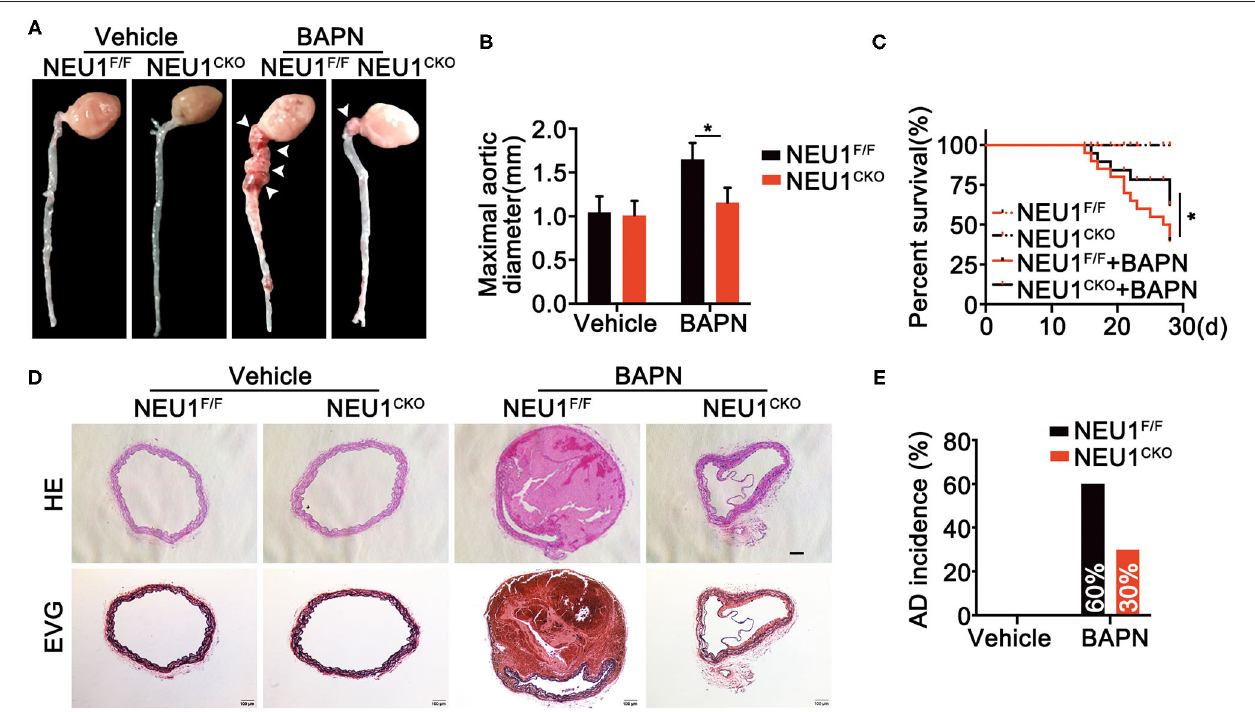
FIGURE 3 | Macrophage-specific NEU1 knockout (NEU1 CKO) deficiency mitigates BAPN-induced AD development. (A–E) , NEU1 F / F and NEU1 CKO mice were subjected to BAPN induction. (A) Representative macrographs of the aortas. (B) Maximal aortic diameter ( n = 9, * p < 0.05). (C) Kaplan–Meier survival analysis of indicated groups ( n = 20, * p < 0.05). (D) Representative HE and EVG staining of the aorta. (E) AD incidence in indicated groups ( n = 20). AD, aortic dissecting; BAPN, β -aminopropionitrile monofumarate; HE, hematoxylin and eosin; KO, knockout; NEU1, neuraminidase